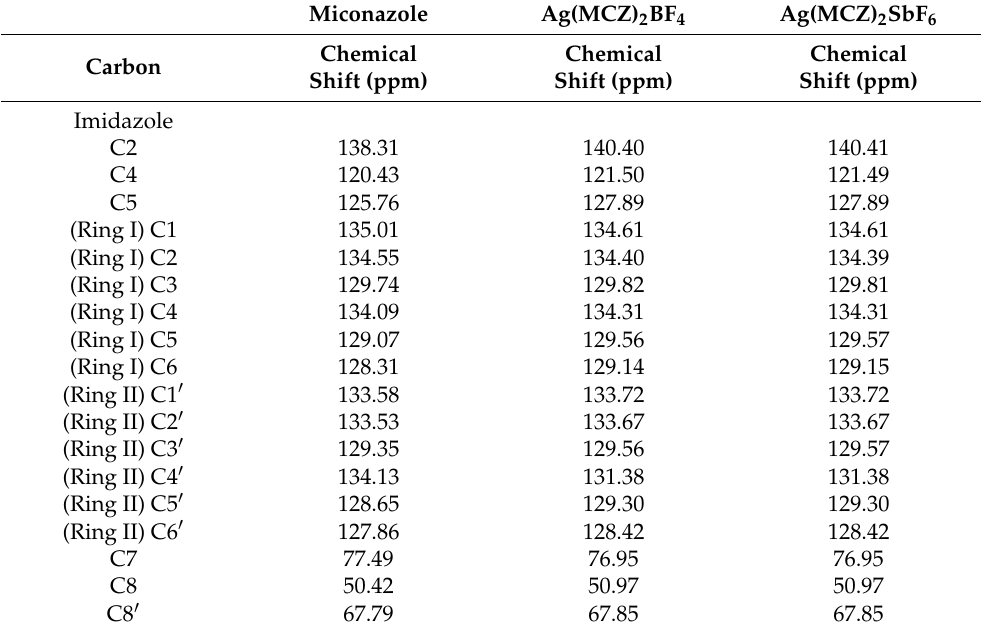
Table 2. 13 C NMR spectroscopy data for silver(I) complexes and the free